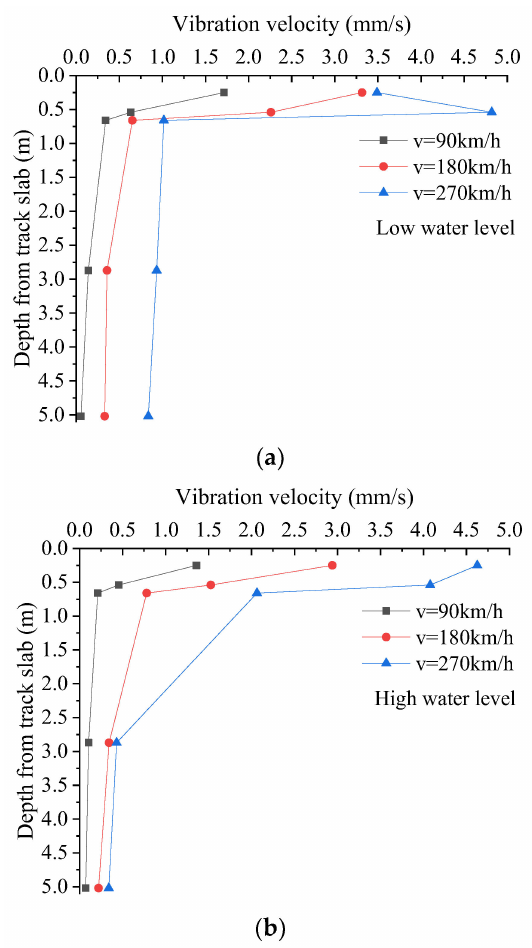
Figure 15. Vibration velocity distribution in vertical direction along the depth from roadbed. ( a ) low water level, ( b ) high water